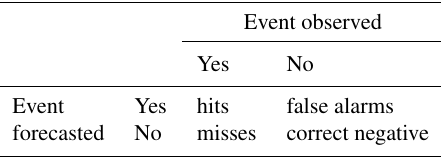
Table 2. Contingency table of dichotomous events illustrating the four types of classification between observed and forecasted